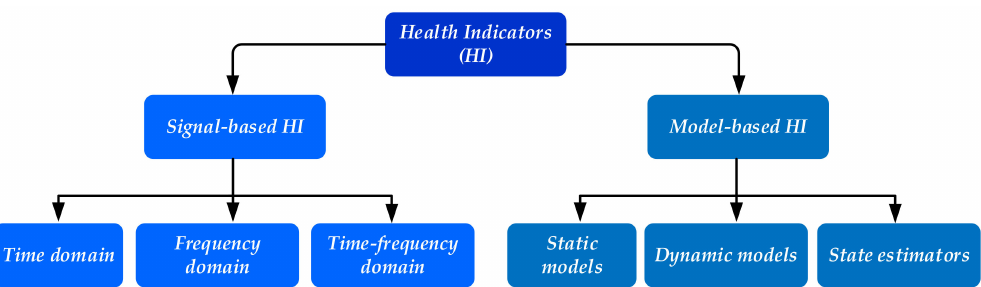
Figure 9. Designing HIs using signal-based and model-based methods. Reproduced from